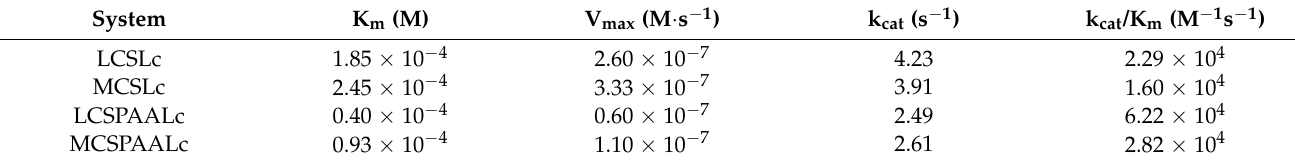
Figure 5. The Lineweaver–Burk plots of Lc immobilized on different microspheres (the lines are best fit of the obtained experimental data with the Michaelis–Menten model). The obtained parameters—K m , V max , and k cat —are listed in the Table 1. Table 1. Michaelis–Menten parameters